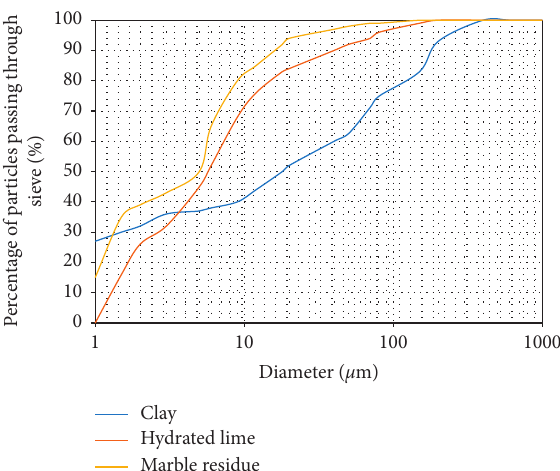
Figure 5: Granulometric curve of hydrated lime, clay, and marble waste.